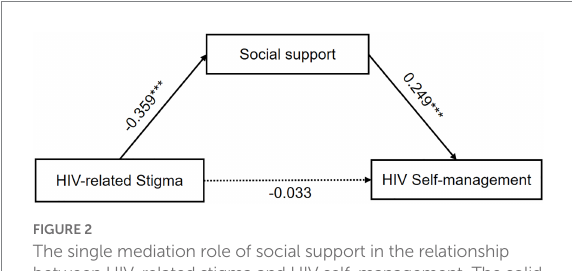
FIGURE 2 The single mediation role of social support in the relationship between HIV-related stigma and HIV self-management. The solid line and dashed line indicated significant and non-significant path coefficients, respectively. *** p < 0.001.